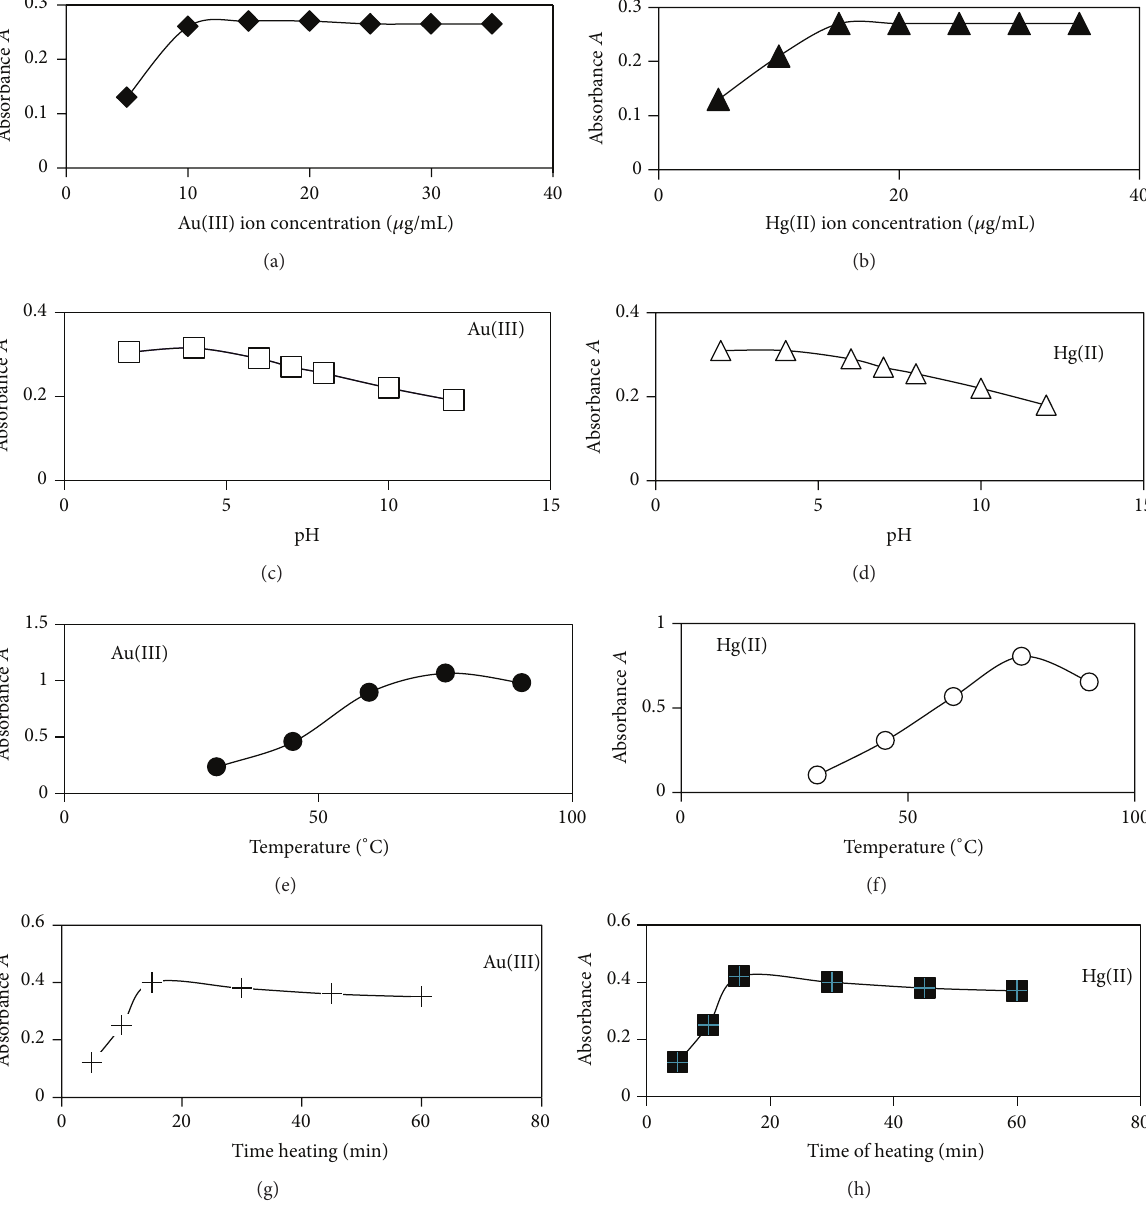
Figure 3: Optimum absorbance conditions for tetracycline Au(III) and Hg(II) complexes.